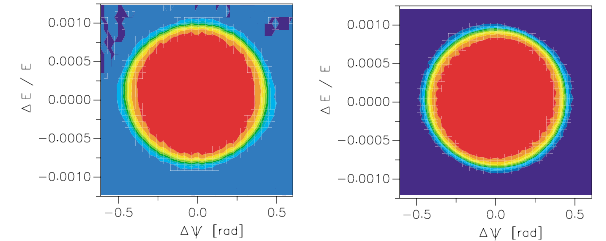
FIG. 1. (Color) Tomographic reconstructions of a circular phase space density distribution using the code described in this paper (left panel) and the CERN code [1] (right panel).